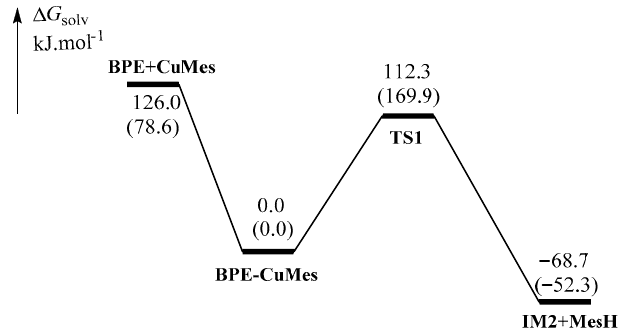
Figure 2. Energy diagram for the formation of the intermediate IM2 . Δ G solv (in kJ mol − 1 ) are calculated at the M06(SMD,THF)/6-311+G(d,p) level; Δ G solv (in kJ mol − 1 ) at the B3LYP/(SMD,THF)/6-311+G(d,p) level are listed in parentheses.